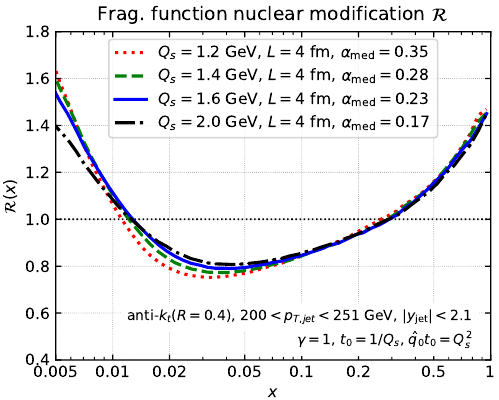
Figure 6. Monte-Carlo calculation of the nuclear modification factor for the jet fragmenta- tion